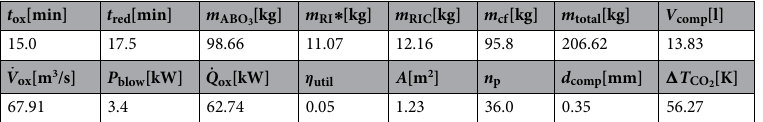
Table 9. Chosen case EuNiO 3 -Cm 2 O 3 (95% 244 Cm) calculation results; T ox = 300 ◦ C , T red = 500 ◦ C . ∗ m 244 Cm ( 95% ) of 11.1kg corresponds to a thermal power (